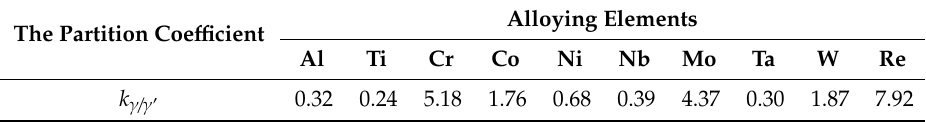
Table 2. The averaged partition coe ffi cients k γ / γ (cid:48) obtained for the alloying elements of the